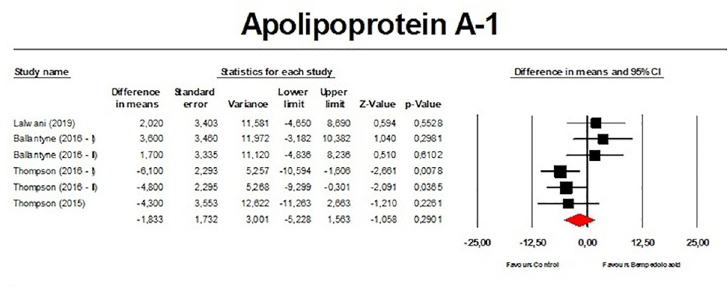
Fig 12. Forest plot displaying mean difference and 95% confidence intervals for the effect of bempedoic acid on plasma levels of apolipoprotein A-1.